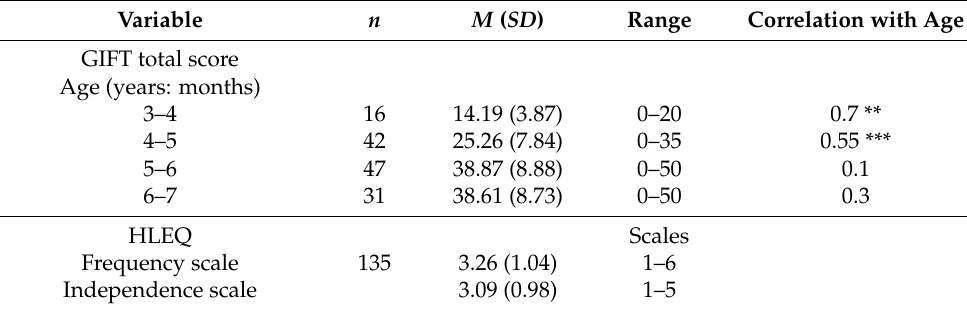
Table 2. Descriptive information: GIFT and HLEQ.